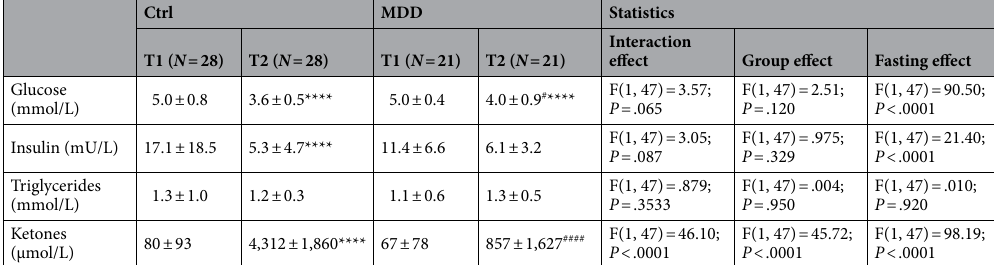
Table 1. Comparison of metabolic parameters pre- and post-fasting in Ctrl and MDD. Table depicts mean values ± SD. RM two-way ANOVA was performed. Effect sizes for interaction and main effects are depicted. For post-hoc analyses, Sidak’s multiple comparison test was applied. **** P < .0001, versus corresponding T1; #### P < .0001, # P < .05 versus corresponding Ctrl. P < .05 was considered to be statistically